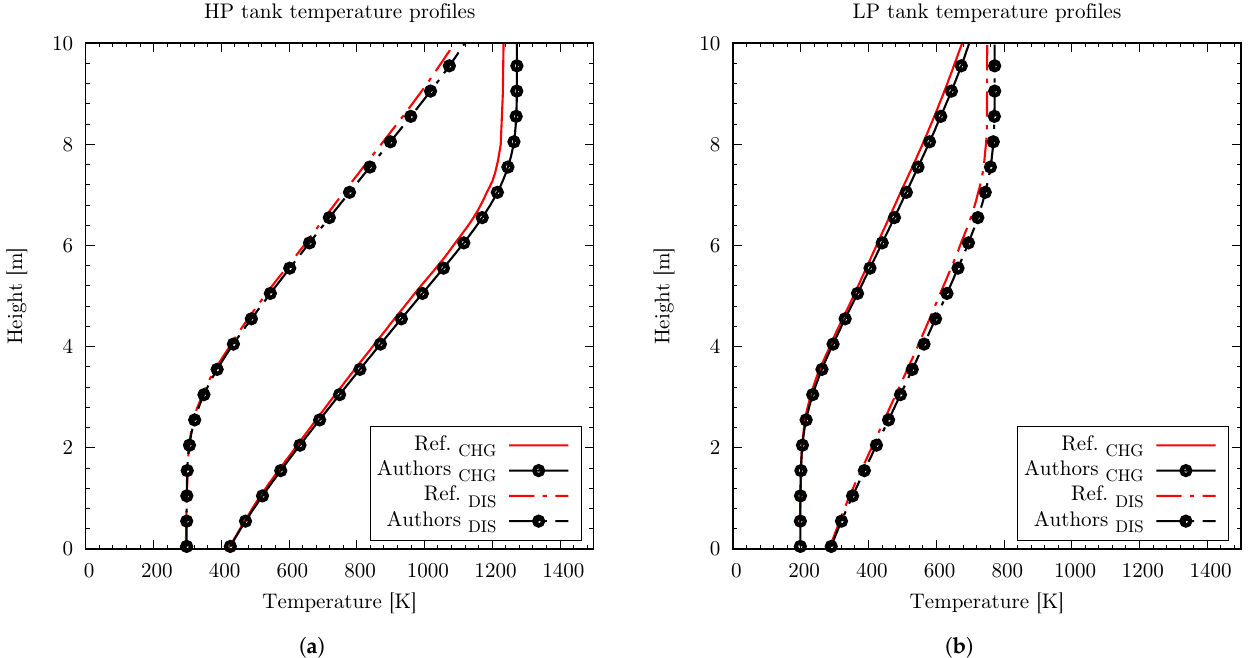
Figure 4. Temperature profiles inside the tanks at the end of the two cycle phases, for a stabilized cycle. ( a ) Temperature trend inside the hot tank. ( b ) Temperature trend inside the cold